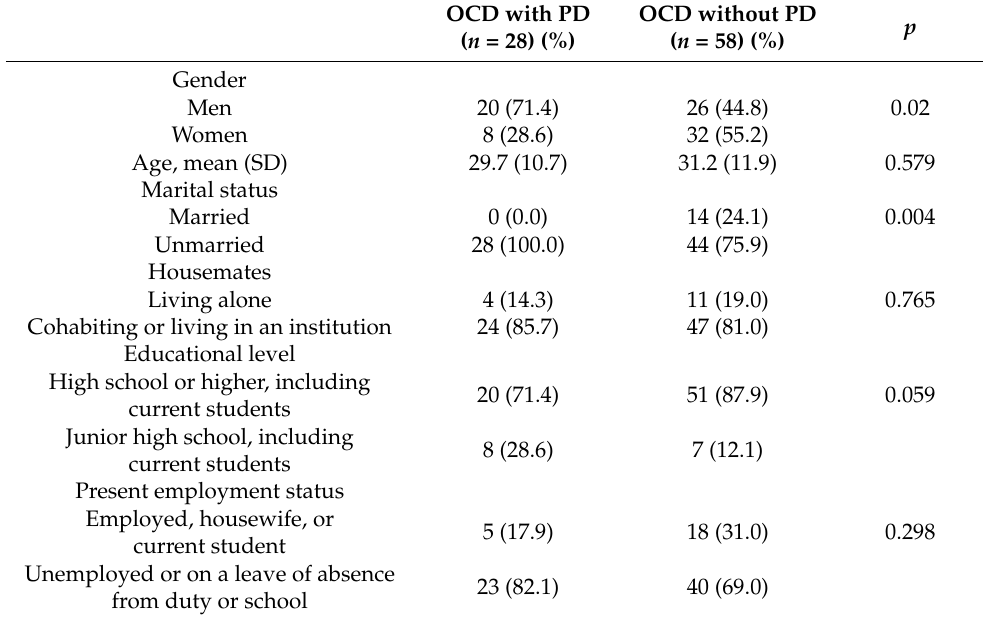
Table 1. Comparison between OCD with psychotic disorder ( n = 28) and OCD without psychotic disorder ( n = 58): sociodemographic profiles and clinical